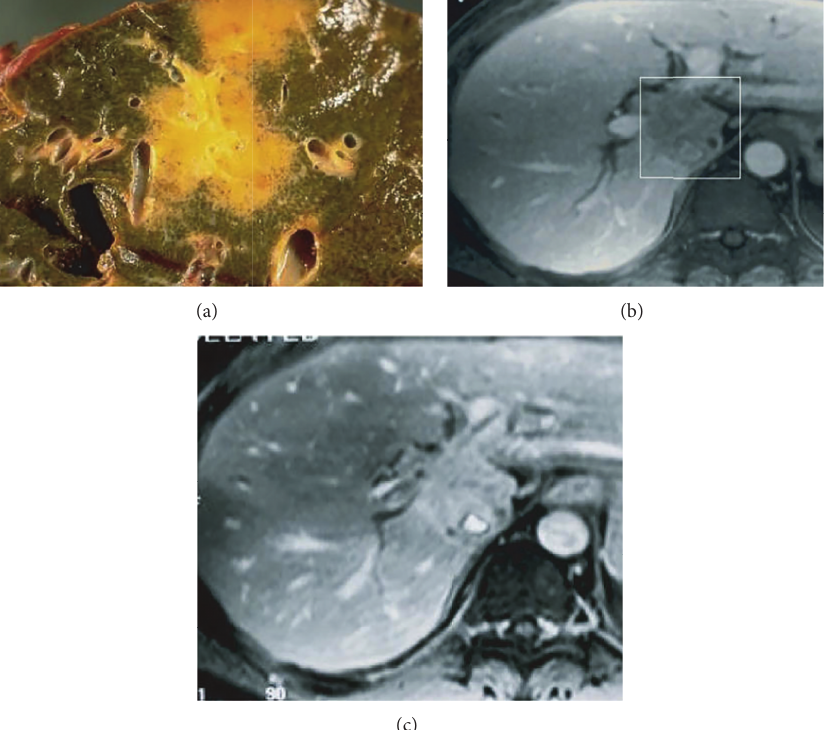
Figure 2: MRI and pathologic correlation of intrahepatic cholangiocarcinoma. (a) Yellow-grey intrahepatic mass on pathologic specimen. (b) Portal venous phase MRI of intrahepatic cholangiocarcinoma designated by box with hypointense lesion. (c) Delayed contrast-enhanced MRI of the same lesion showing accumulation of contrast within the lesion. Reprinted from Cancer Imaging